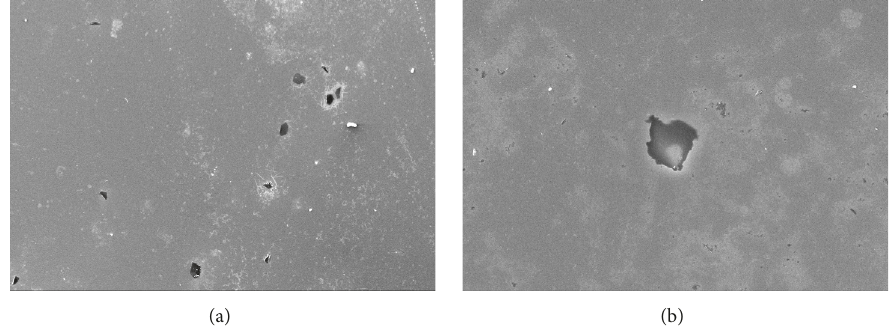
Figure 5: Pitting corrosion observed with SEM on the DLC film surface after the potentiodynamic tests: (a) 100x; (b)